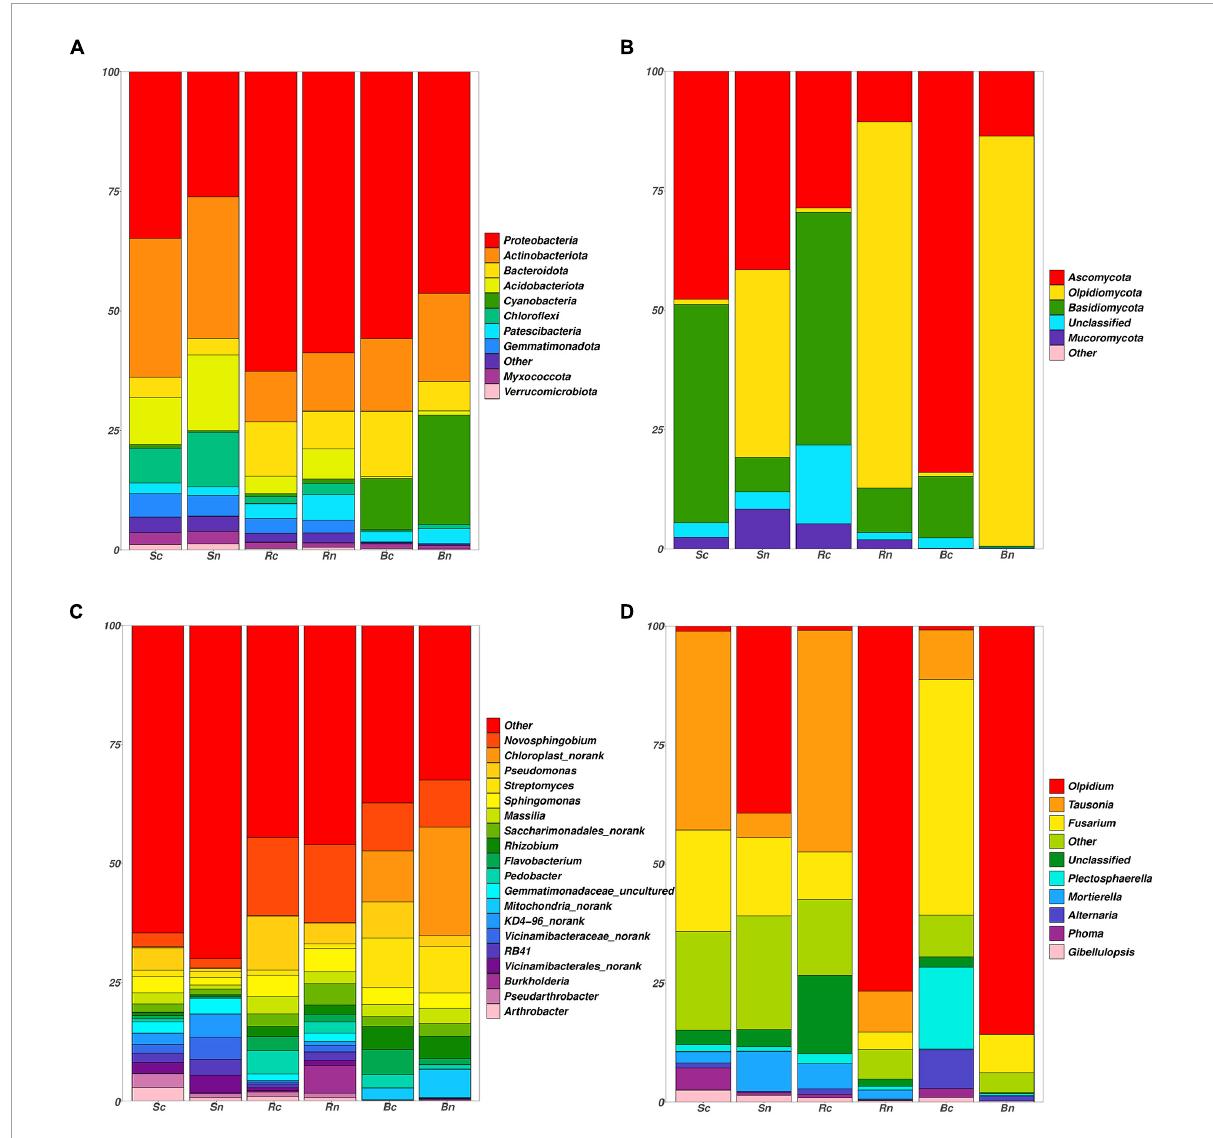
FIGURE3 Phylum and genus level taxonomic differences in bacterial and fungal communities. Distribution of the most abundant bacterial (A) and fungal (B) phyla. The area on the Outer left ring represents the contribution of each phylum in each sample. Distribution of the most abundant bacterial (C) and fungal (D) genera. Sc, continuous cropping bulk soil; Sn, non-continuous cropping bulk soil; Rc, continuous cropping rhizosphere soil; Rn, non-continuous cropping rhizosphere soil; Bc, continuous cropping sugar beetroot; Bn, non-continuous cropping sugar beetroot.